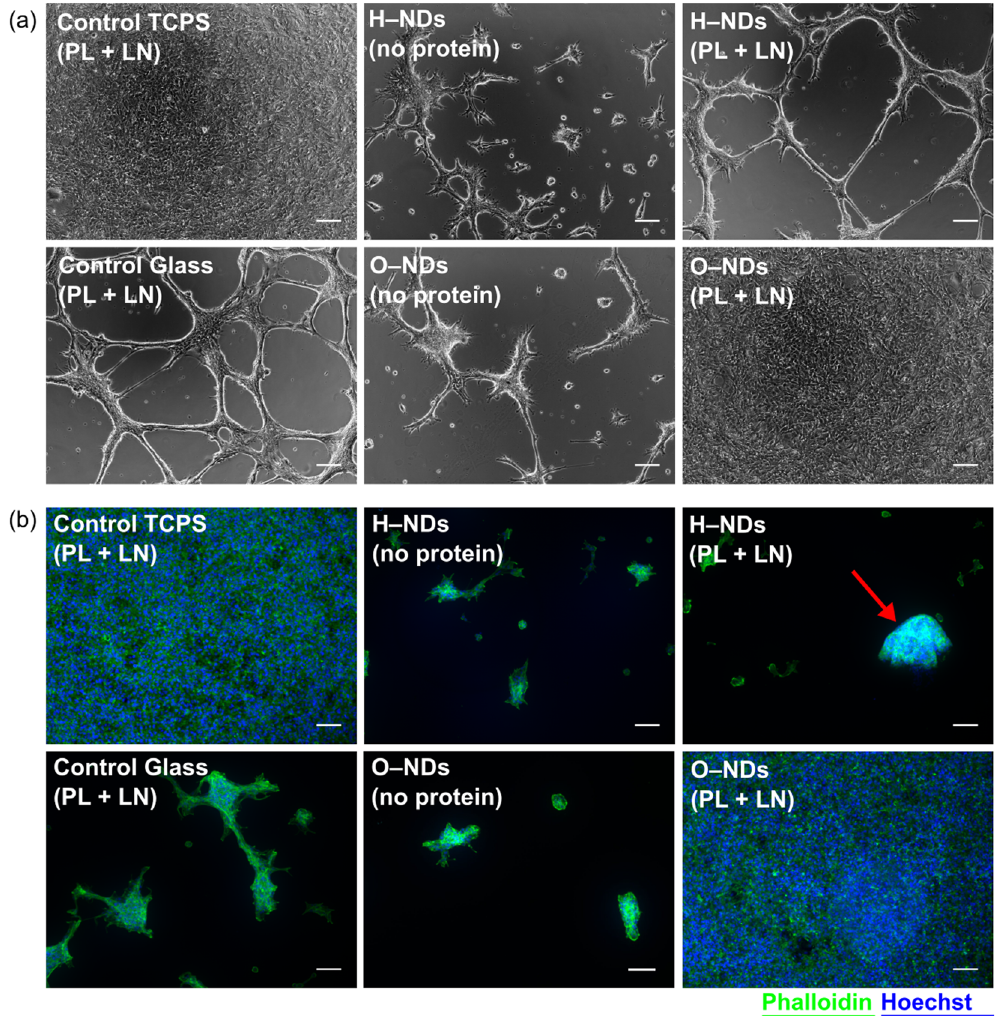
Figure 3. Micrographs of live hNSCs and cell stained for actin grown on different surfaces: ( a ) optical images of live hNSCs after 4 DIV (days in vitro ) which have been cultured on Control TCPS, Control Glass H–NDs and O– NDs, with and without PL + LN (Poly-L-lysine + laminin) coating. ( b ) hNSCs fluorescently labelled using Alexa Fluor ® 488 Phalloidin (green) to detect actin and Hoechst dye (blue) to visualize nuclei after 7 DIV on Control TCPS, Control Glass H–NDs and O–NDs, with and without PL + LN coating. The red arrow highlights a potential neurosphere on the H–NDs. Representative images for each substrate are shown. All scale bars are 100 µ